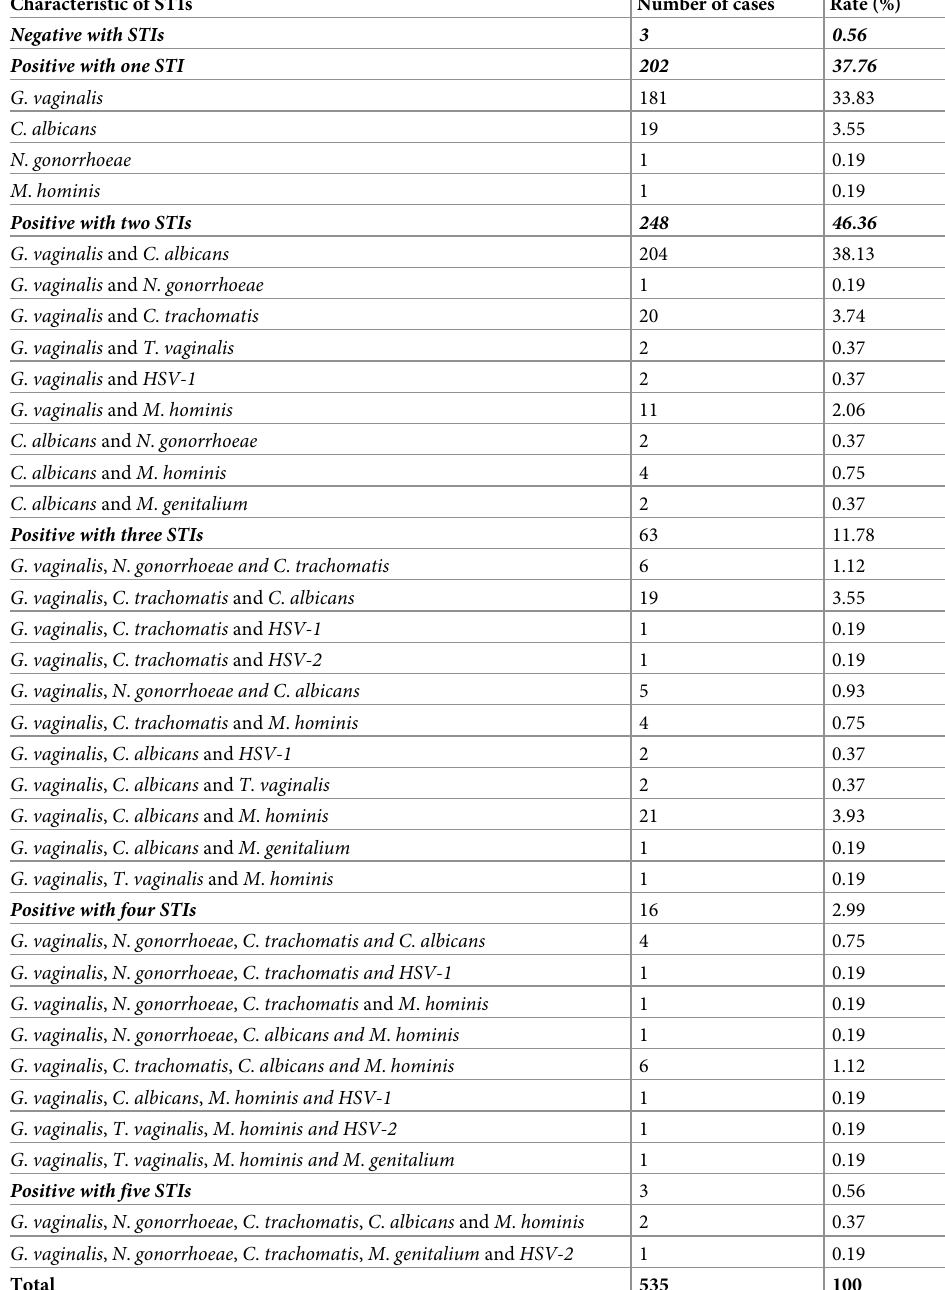
Table 6. Prevalence of STIs that were screened using multiplex real-time PCR TaqMan probe. Characteristic of